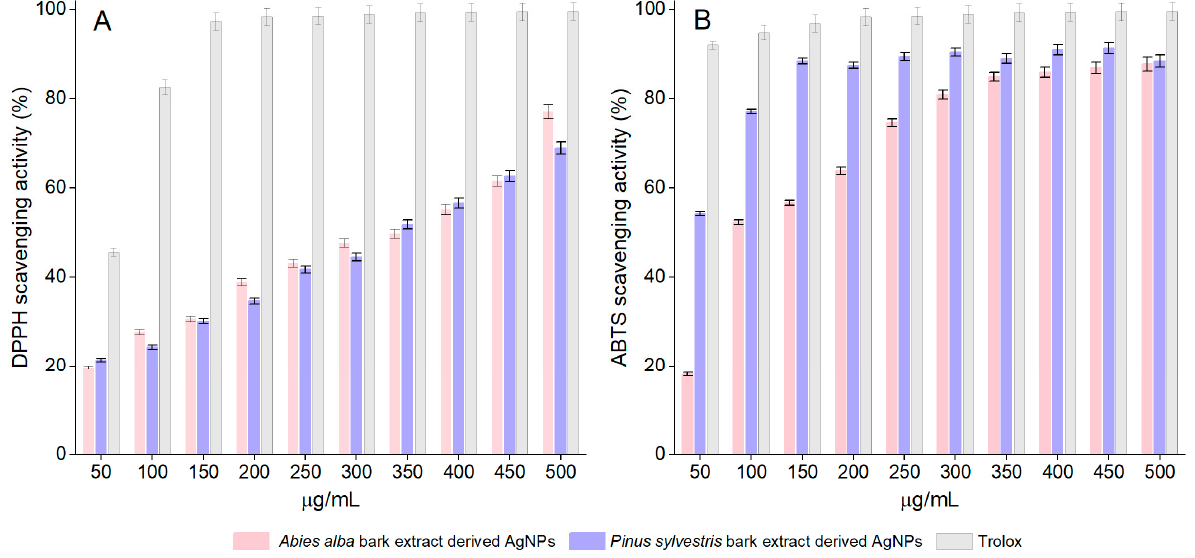
Figure 6. DPPH scavenging activity ( A ) and ABTS scavenging activity ( B ) of Abies alba and Pinus sylvestris bark extract-derived AgNPs and Trolox; significant differences ( p < 0.001) between Abies alba / Pinus sylvestris bark extract-derived AgNPs and Trolox (at all tested